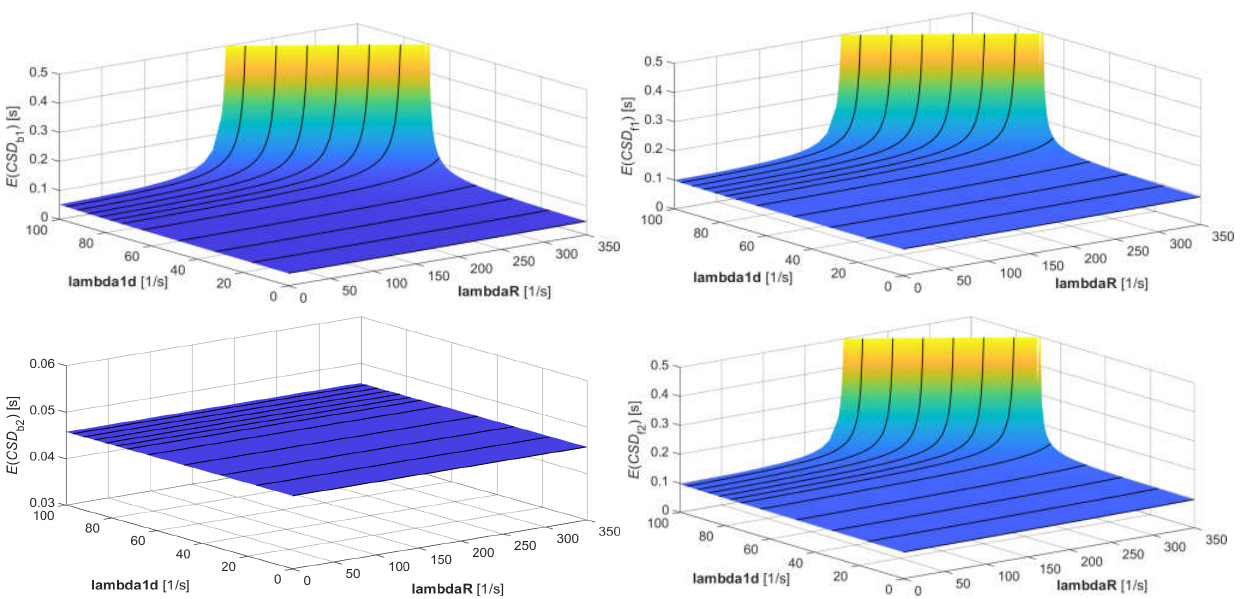
Figure 4. Selected results for data set 1 from Table 1.